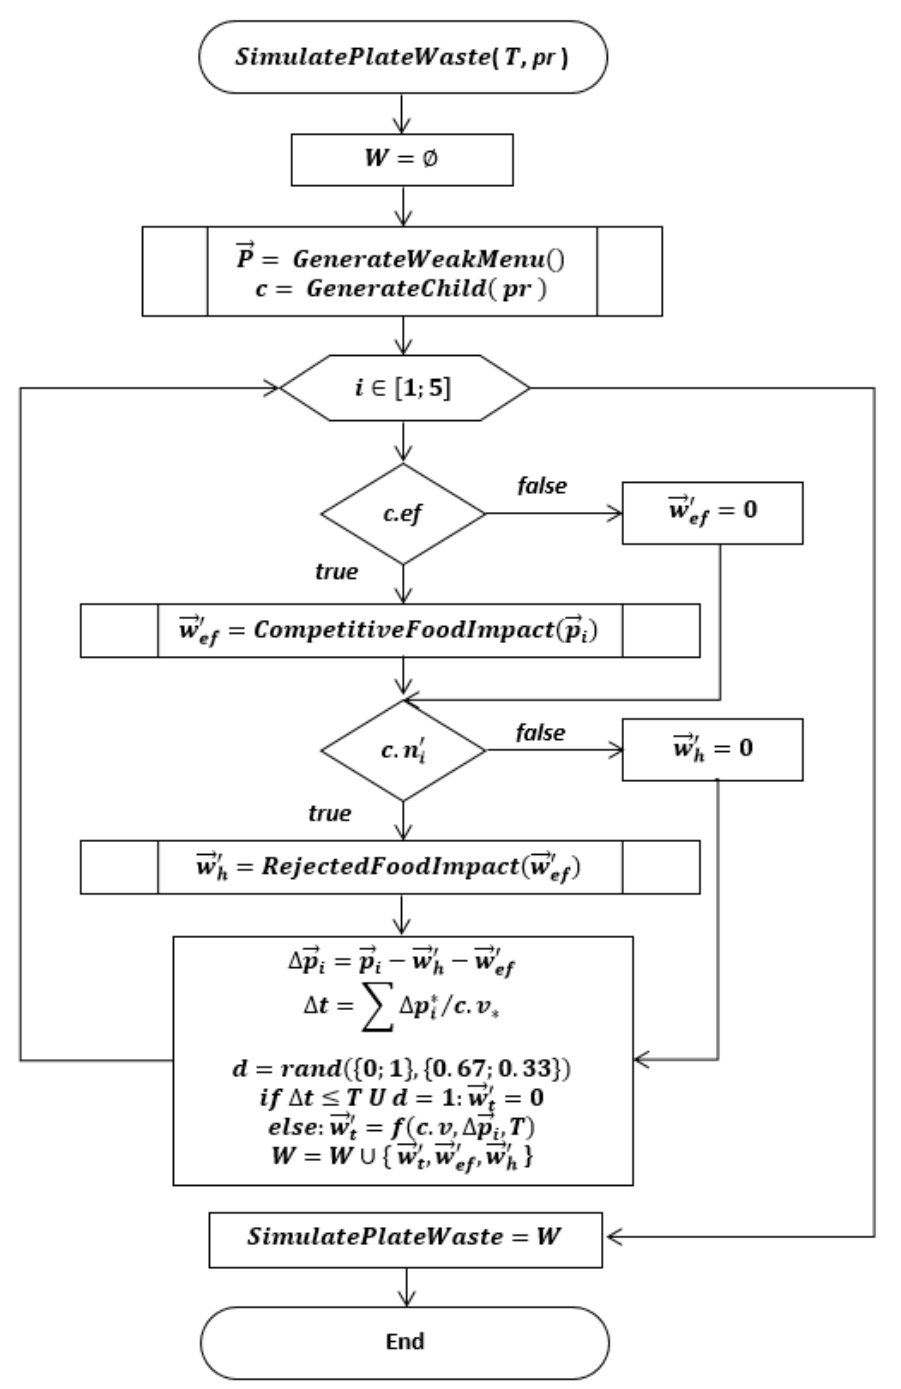
Figure 7. Flowchart of plate waste simulation.